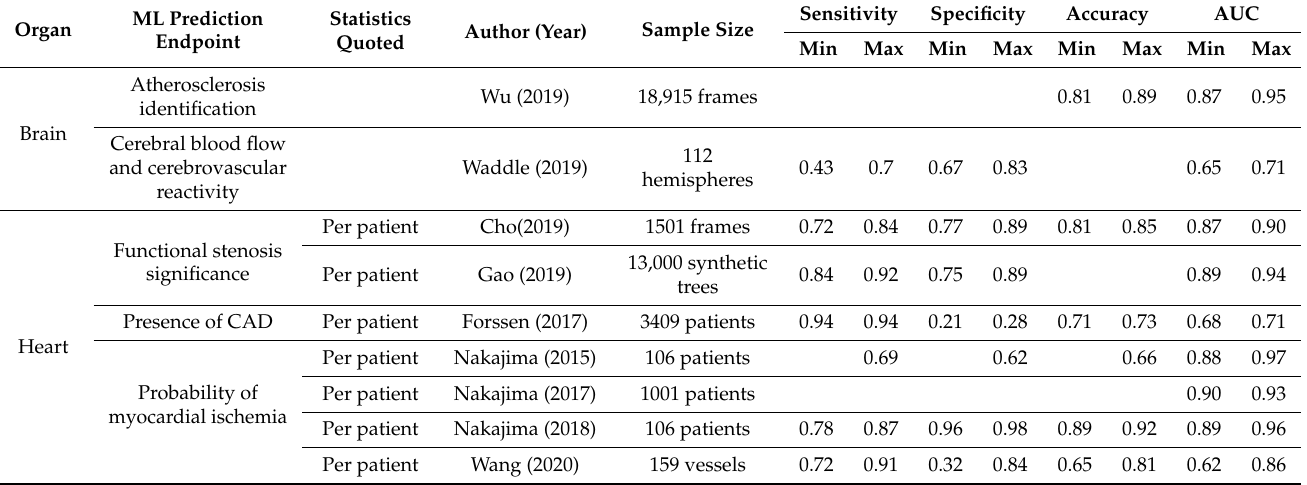
Table 7. Model performance statistics for ML quantitation using modalities other than CT and ultrasound. ML Prediction Organ